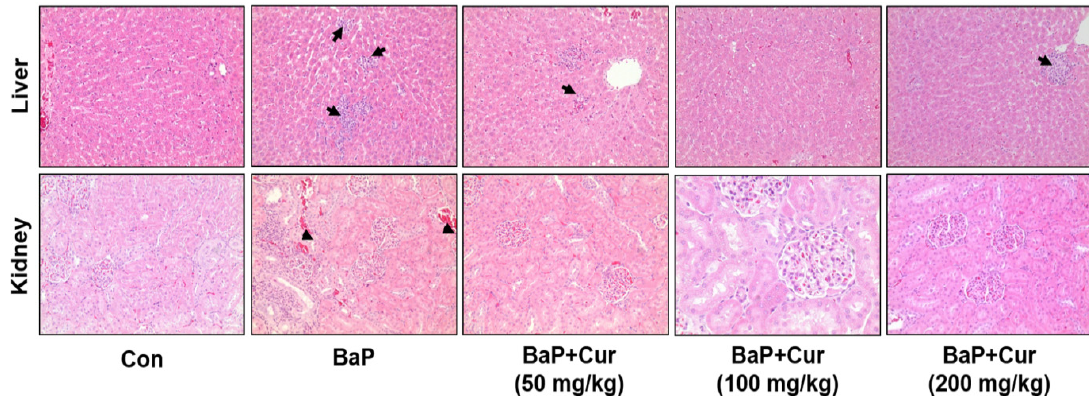
Figure 2. Effects of curcumin on histopathological changes in liver and kidney of rats treated with benzo[a]pyrene (BaP). Rats were orally administrated (BaP alone (20 mg / kg) or in combination with curcumin (50, 100, or 200 mg / kg) for 30 days. The control group was administered vehicle only. Representative histology of hematoxylin and eosin (H&E)-stained liver and kidney sections from experimental groups. Arrows displayed cell infiltration, mononuclear cells, and multifocal cells. Table 3. Histopathological Changes in Liver and Kidney of Sprague-Dawley Rats. Groups Control Groups